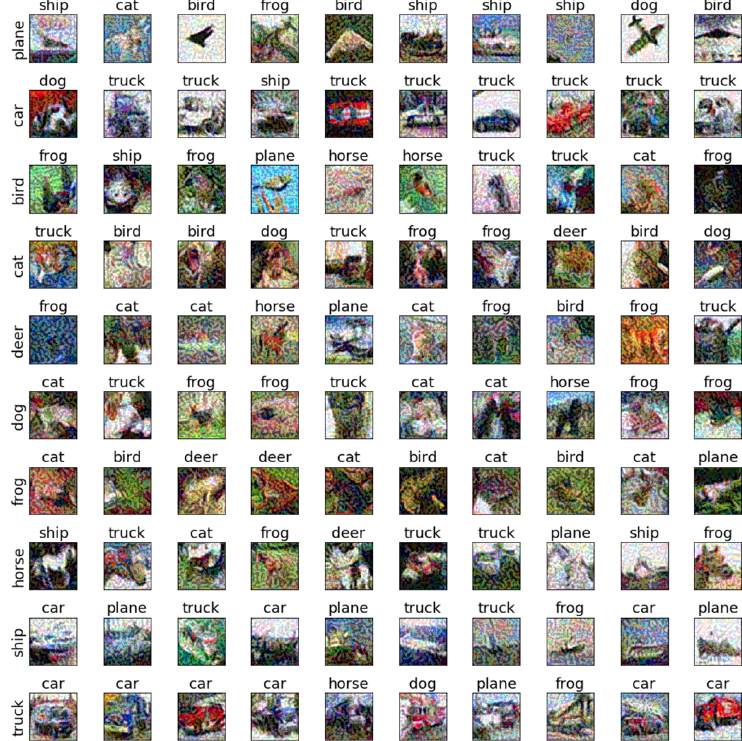
Figure 11. The adversarial examples of PGD for Cifar10 and AlexNet.